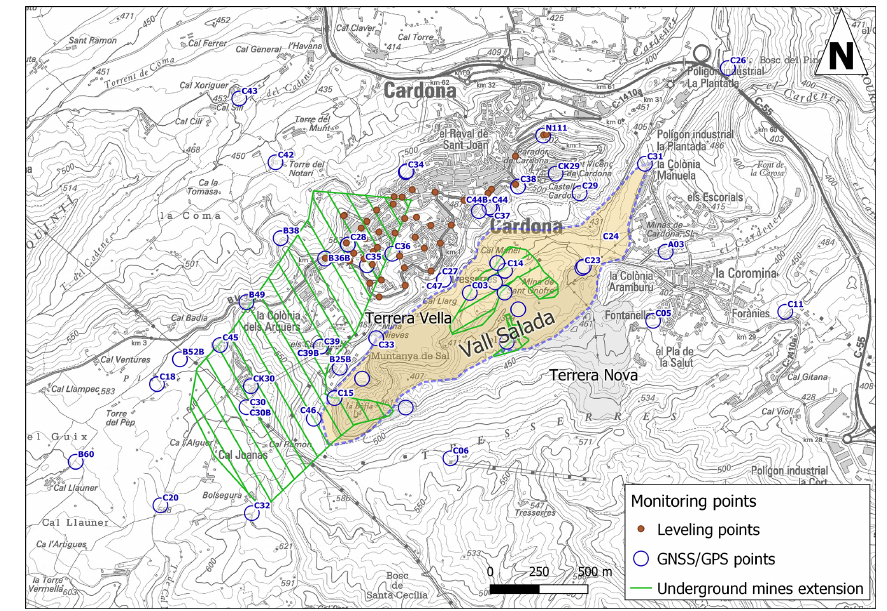
Figure 2. Different locations of the Cardona area including the underground mine extension and the Situation of the GNSS/GPS and levelling